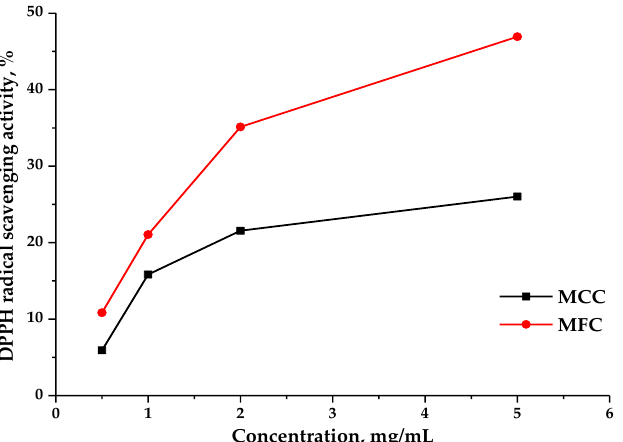
Figure 11. DPPH radical scavenging at different concentrations of the MCC and MFC in